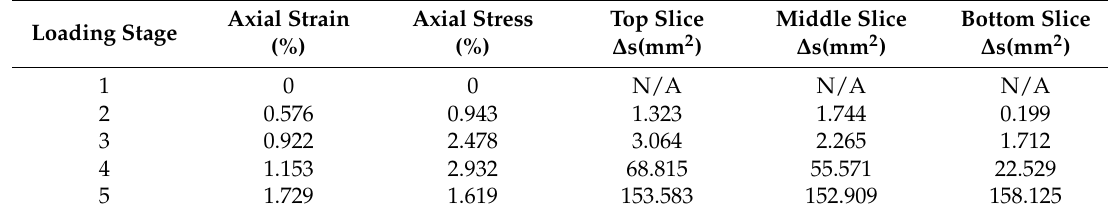
Table 4. Stress-dilatancy characterization of the CWRB sample under uniaxial compression.